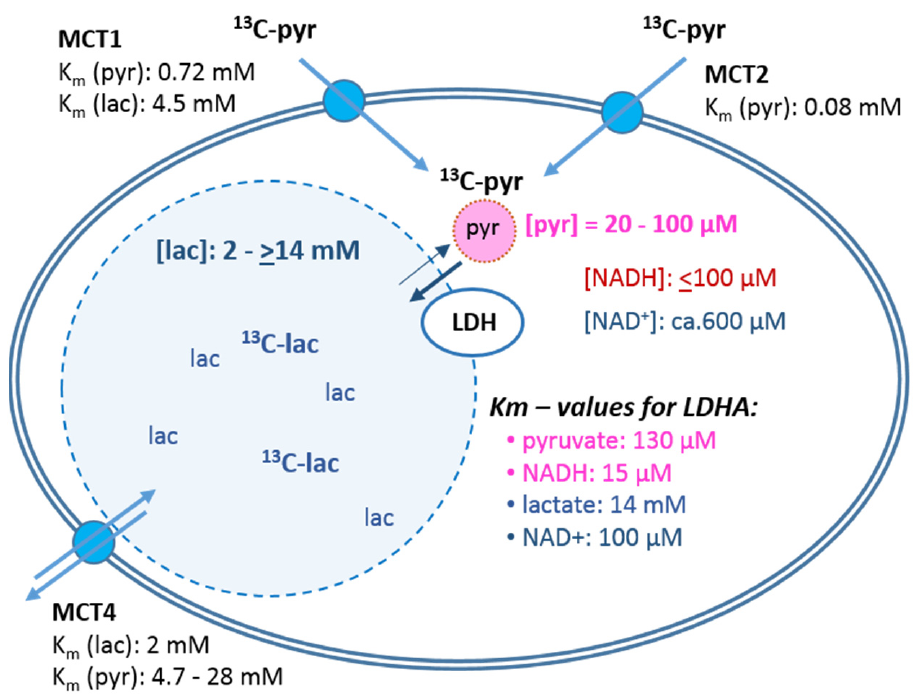
Figure 3. Cellular parameters affecting the rate of pyruvate to lactate conversion. The scheme depicts cellular components for the uptake and conversion of pyruvate to lactate. Depicted is a cell with the intracellular spaces (shaded) representing the relative pool sizes of pyruvate and lactate (ratio approx. 1:50). Shown are intracellular concentrations of substrates and coenzymes from MCF-7 and MDA-MB-231 cells (Section 3.4) as well as K M -values reported for LDH activity by other sources [49,50]. The K M -values for the different monocarboxylate transporters (MCT) are as reported by